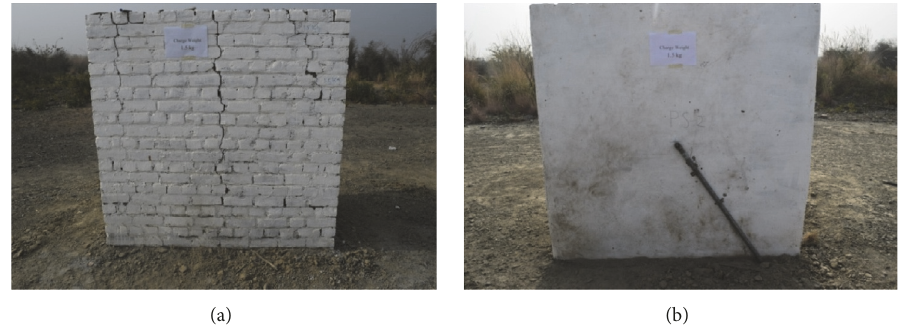
Figure 17: (a) Major shear and flexural cracks in unreinforced masonry wall and (b) no damage ferrocement wall.